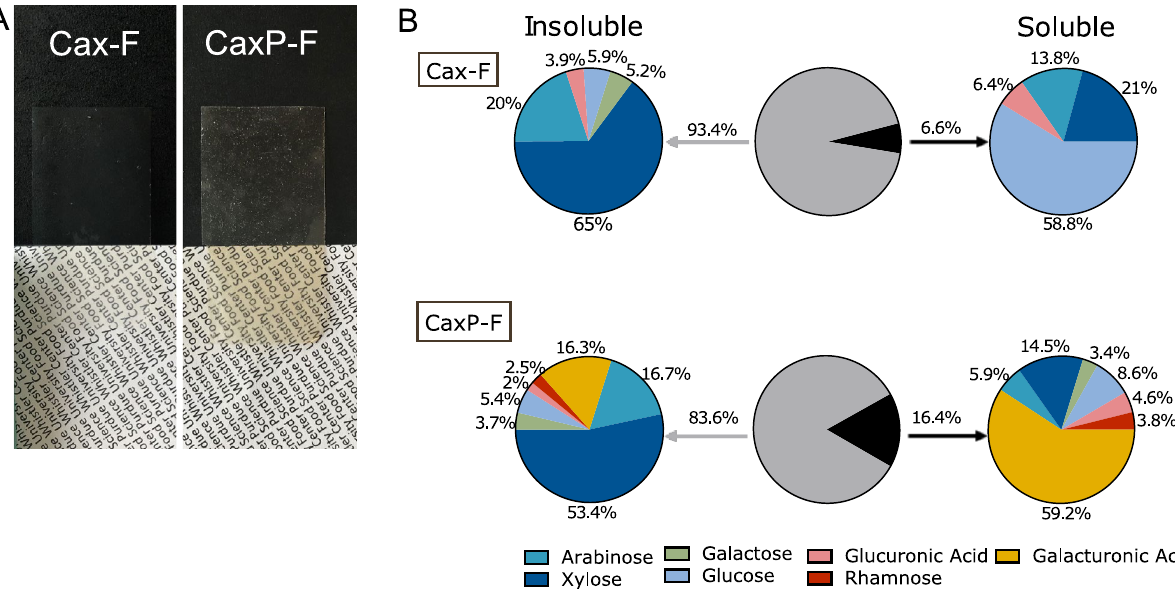
Figure 2. ( A ) Visual appearance of arabinoxylan film (Cax-F) and arabinoxylan film with embedded pectin (CaxP-F), ( B ) Monosaccharide profiles of insoluble and soluble portions of films. The pie chart in the middle represents the percentage of the films that was insoluble and